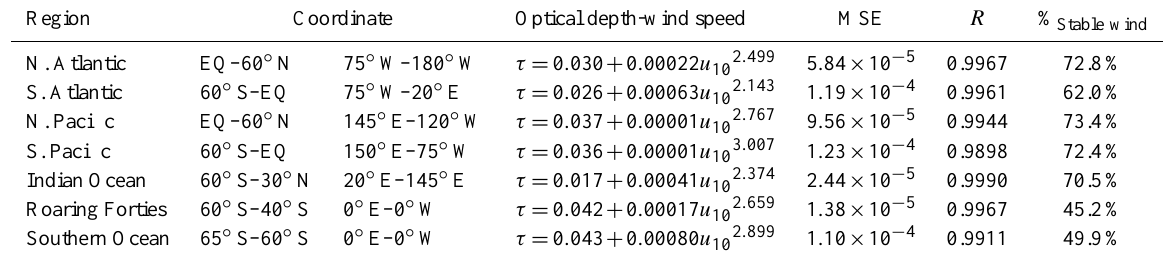
Table 4. Aerosol optical depth ( τ )-wind speed ( u 10 ) dependence of the fitting function in global oceanic regions. Region